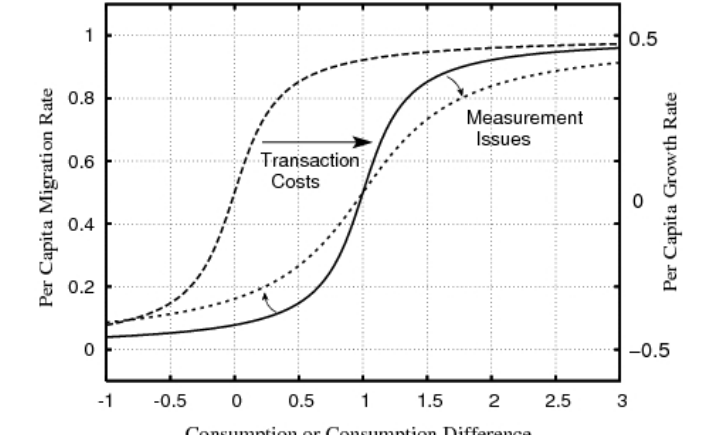
,b ) = 0.5 + arctan(a (x - b ))/ p m m m m and b . The m m